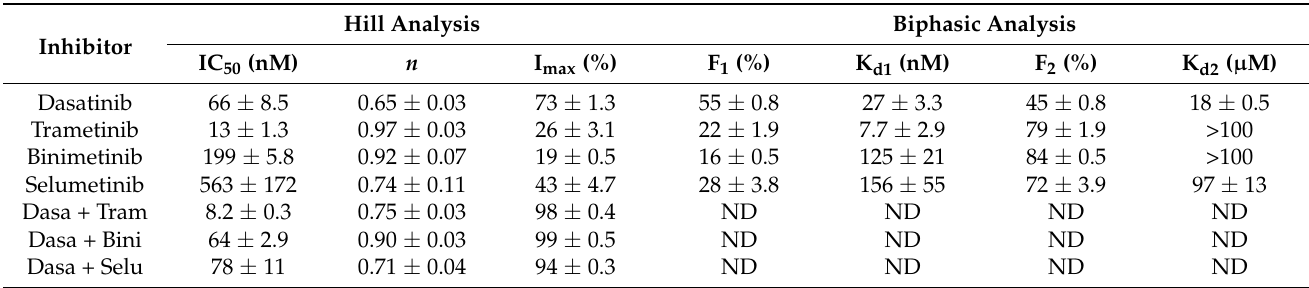
Table 4. Inhibition 1 of MDA-MB-231 by individual and combination PKIs.